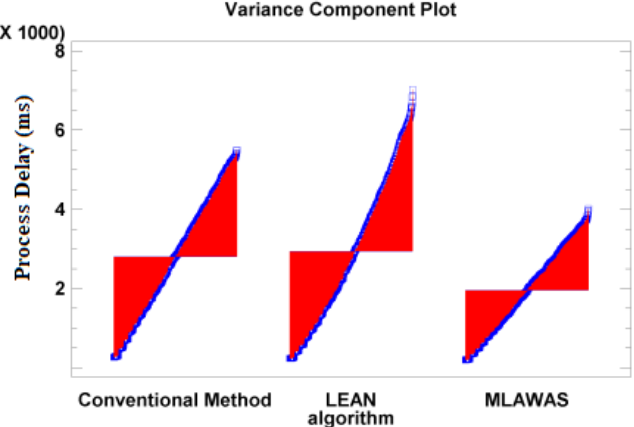
Figure 7. Communication Delay of Workload During Offloading. The round-trip time (RTT) is shown in seconds during offloading and execution in the cloudlet-based cloud network. The E-Transport determines the round-trip from the wireless to the cloudlet or cloud computing nodes. Figure 8 shows that MLAWAS gained a smaller round-trip delay during the offloading and execution of the workload in the network.